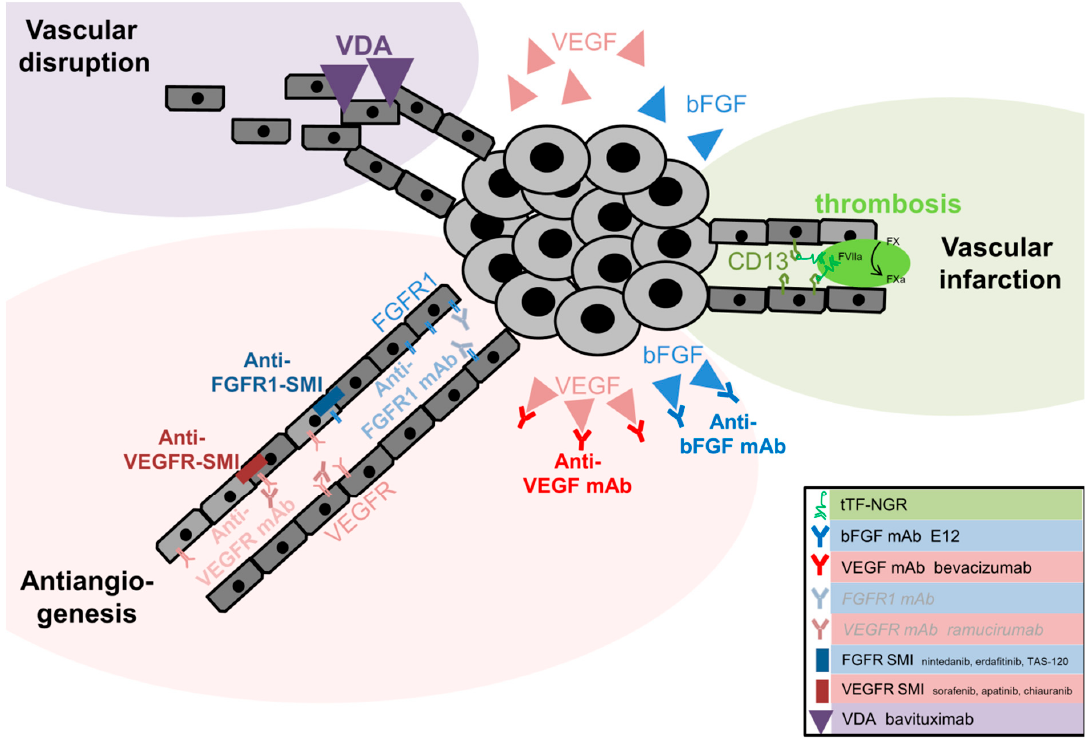
Figure 1. Targeted therapies in the vascular system of SCLC. [97–99]. ( a ) Antiangiogenesis: There is an autocrine stimulation of SCLC by the secretion of ‘basic fibroblast growth factor’ (bFGF) and ‘vascular endothelial growth factor’ (VEGF). The latter activates the receptors FGFR and VEGFR and thus induces angiogenesis. Binding of bFGF and VEGF by monoclonal antibodies (mAb) interferes with the signaling cascade. Its receptors may be influenced by monoclonal antibodies or small molecule inhibitors (SMI) such as erdafitinib or TAS-120 for FGFR and apatinib or chiauranib for VEGFR. ( b ) Vascular infarction: The truncated tissue factor-NGR fusion protein binds CD13 on tumor endothelial cells and induces the extrinsic coagulation cascade by activating factor X. ( c ) Vascular disruption: bavituximab binds the phosphatidylserine of tumor vasculature and induces cellular inflammation.